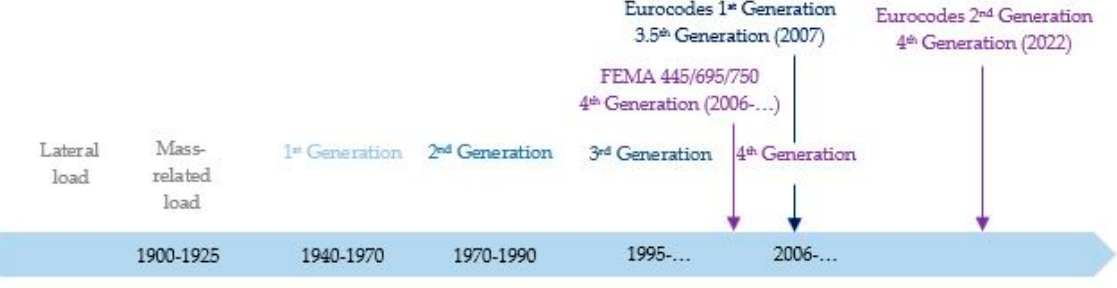
Figure 6. Design philosophy generations and main standards timeline.